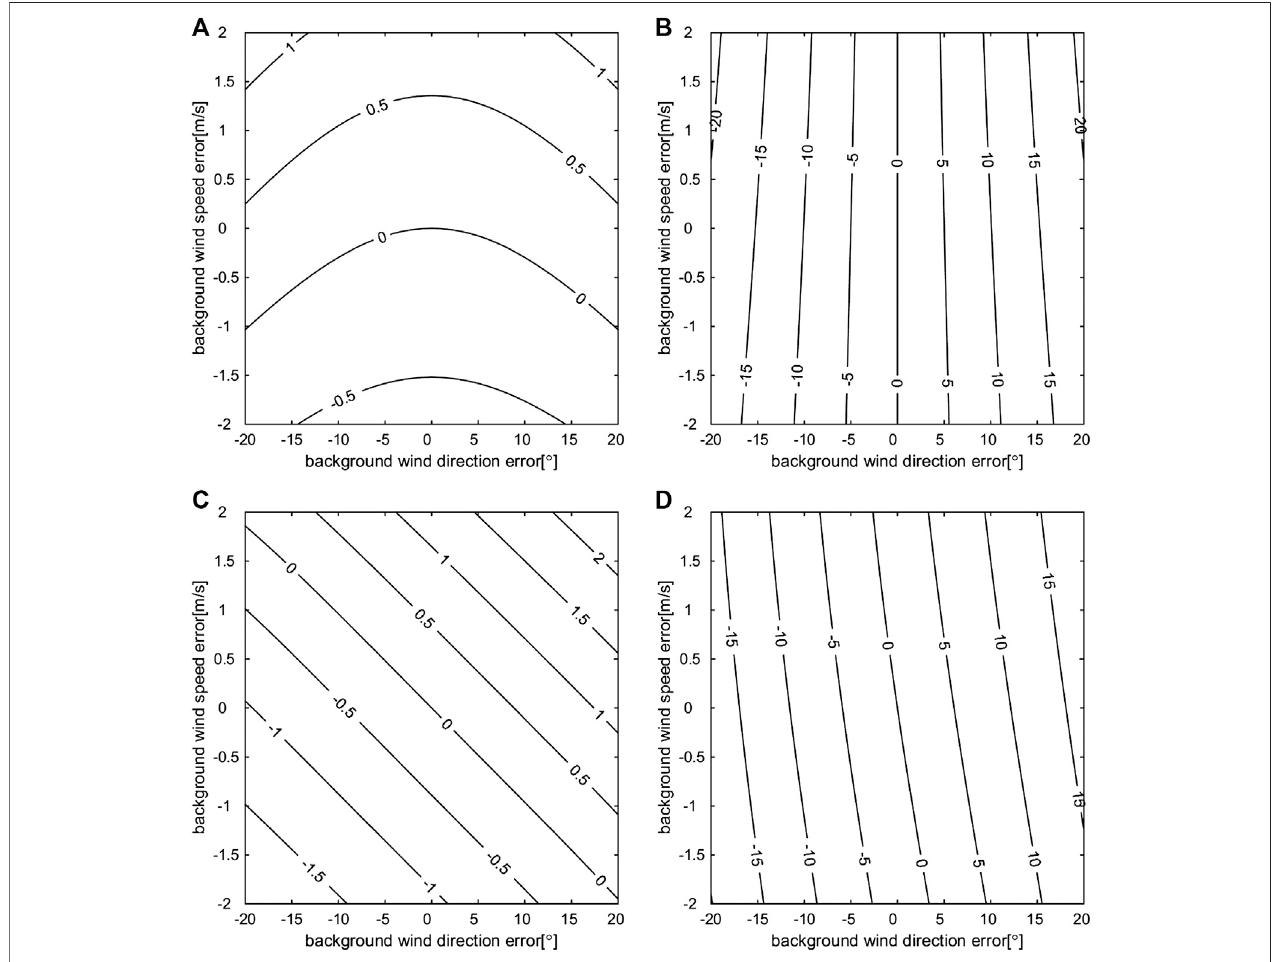
FIGURE3| OI-retrievedwindspeederrors (A , C) andwinddirectionerrors (B , D) (theisolines)whenthetruespeedis12 m/s,andthetruewinddirectioniseither0 ° (A , B) or 45 ° (C , D) ; the background wind speed errors (Y axis) and the background wind direction errors (X axis) are given.